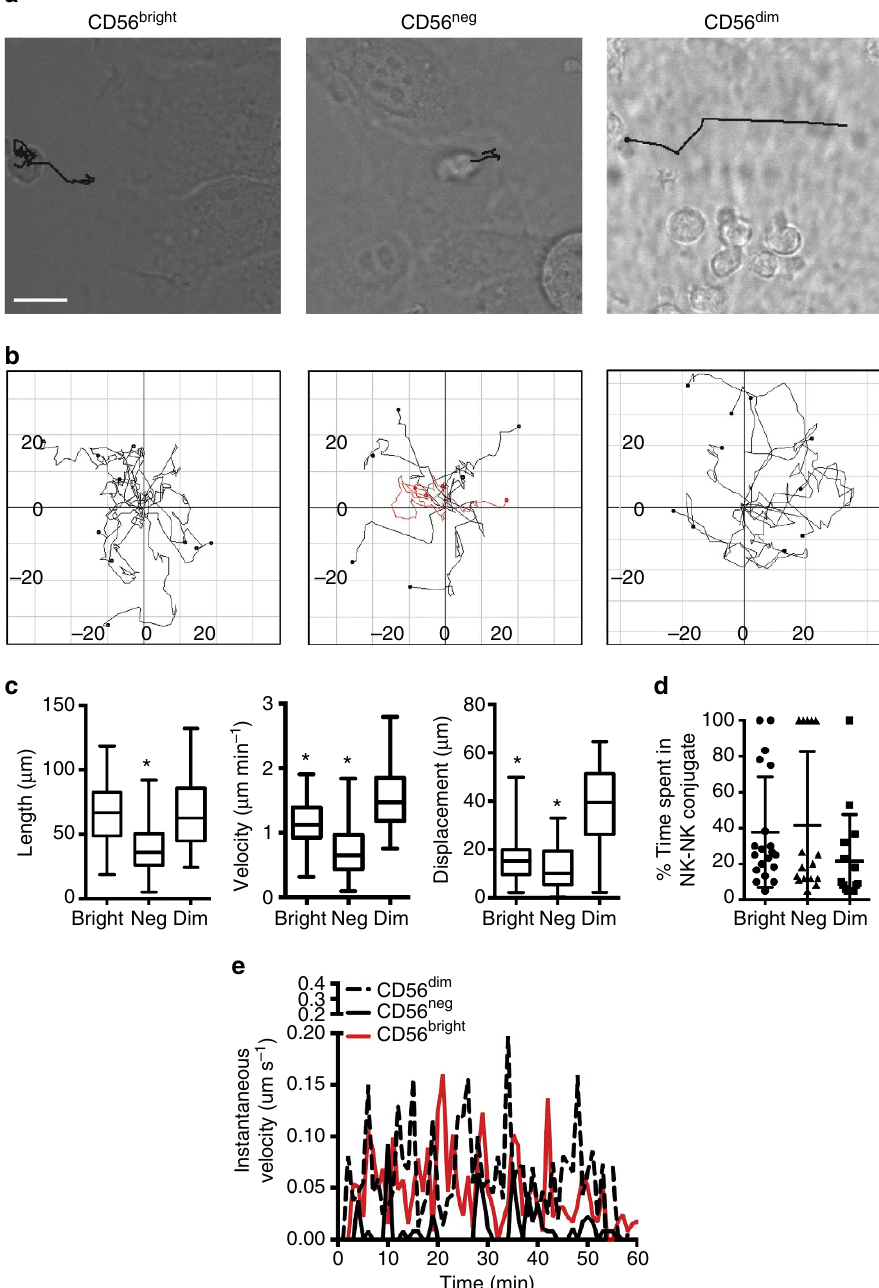
Figure 1 | Human NK cell subsets show differential motility on developmentally supportive stroma. NK cell subsets were purified from peripheral blood by FACS sorting then incubated on EL08.1D2 stromal cells for 4h before initiation of imaging. Cells were imaged by confocal microscopy for 30min at two frames per minute and tracked using the manual tracking plug-in (FIJI) from start to end of imaging. ( a ) Representative cell from each condition is shown with its track from 0 to 30min. Scale bar, 10 m m. See also Supplementary Movies 1–3. ( b ) Tracks from ten cells per condition were overlaid using the Chemotaxis tool (FIJI). Tracks with mean velocity slower than 1 m m per minute are shown in red. Units ¼ m m. ( c ) Track length, displacement and velocity were measured from live-cell confocal images ( n ¼ 96 [CD56 bright ], 82 [CD56 neg ]; 36 [CD56 dim ], three independent experiments). Data are represented as mean ± s.d. * P o 0.05 by Student’s unpaired t -test. P o 0.0001 by ordinary one-way ANOVA. * P o 0.05 by post hoc Tukey’s comparison with CD56 dim condition. ( d ) NK cells were incubated on EL08.1D2 stroma and imaged 2 frames per min. Duration of contact between individual NK cells and stroma or other NK cells was measured and the percentage of time spent in NK–NK conjugates was calculated ( n ¼ 15–20 per condition from three independent experiments). ( e ) Instantaneous velocity of one cell from the CD56 bright (red) CD56 neg (black) and CD56 dim (black, dashed)